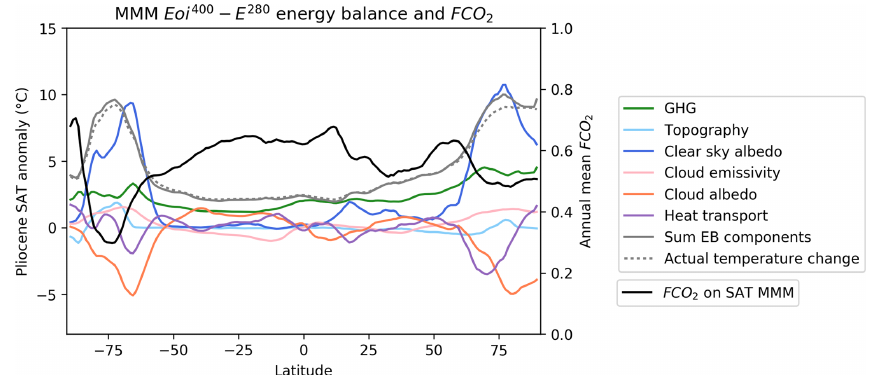
Figure 2. The MMM Eoi 400 –E 280 energy balance with the FCO 2 of the SAT MMM. The MMM includes HadCM3, COSMOS, CCSM4- UoT, CESM2, MIROC4m, and NorESM1-F for both the energy balance and FCO 2 (IPSLCM5A2 is excluded because the required fields were not available for the energy balance analysis). The degree of Pliocene warming attributable to each energy balance component at each degree of latitude is shown, and the sum of the energy balance terms (solid grey line) agrees well with the simulated temperature change (dashed grey line). The FCO 2 of the SAT at 0.70 MMM is shown in the solid black line with a separate axis to compare to the energy balance.